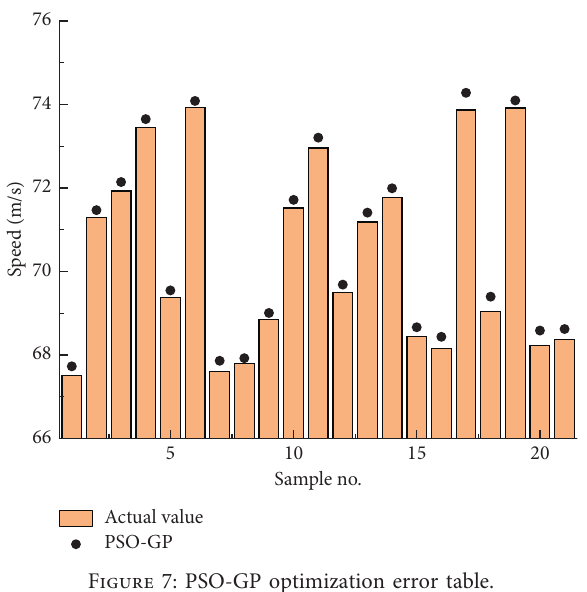
Figure 7: PSO-GP optimization error table.